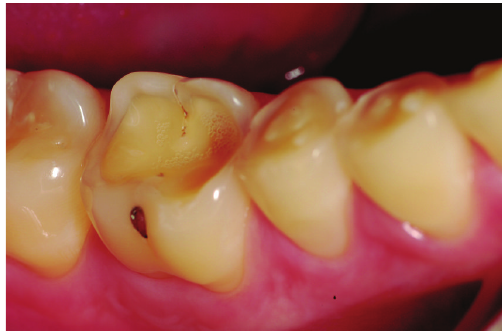
Figure 5: Maxillary arch